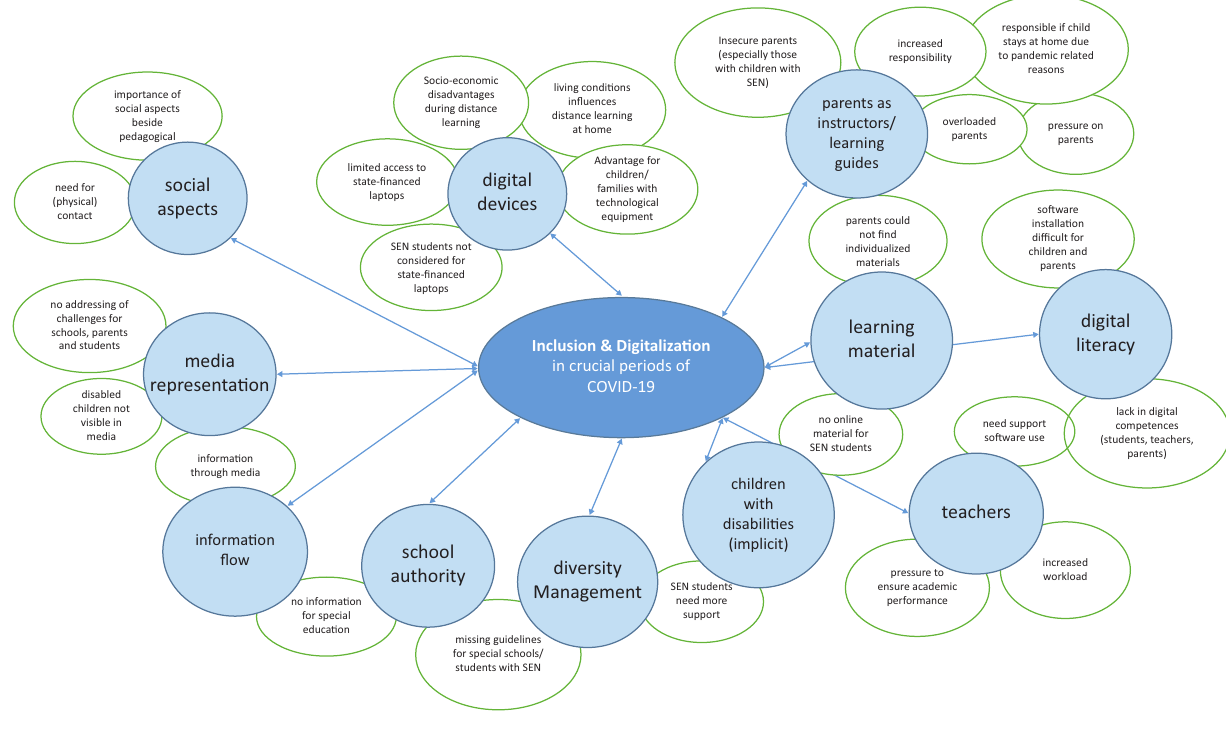
Figure 1. Relational situation